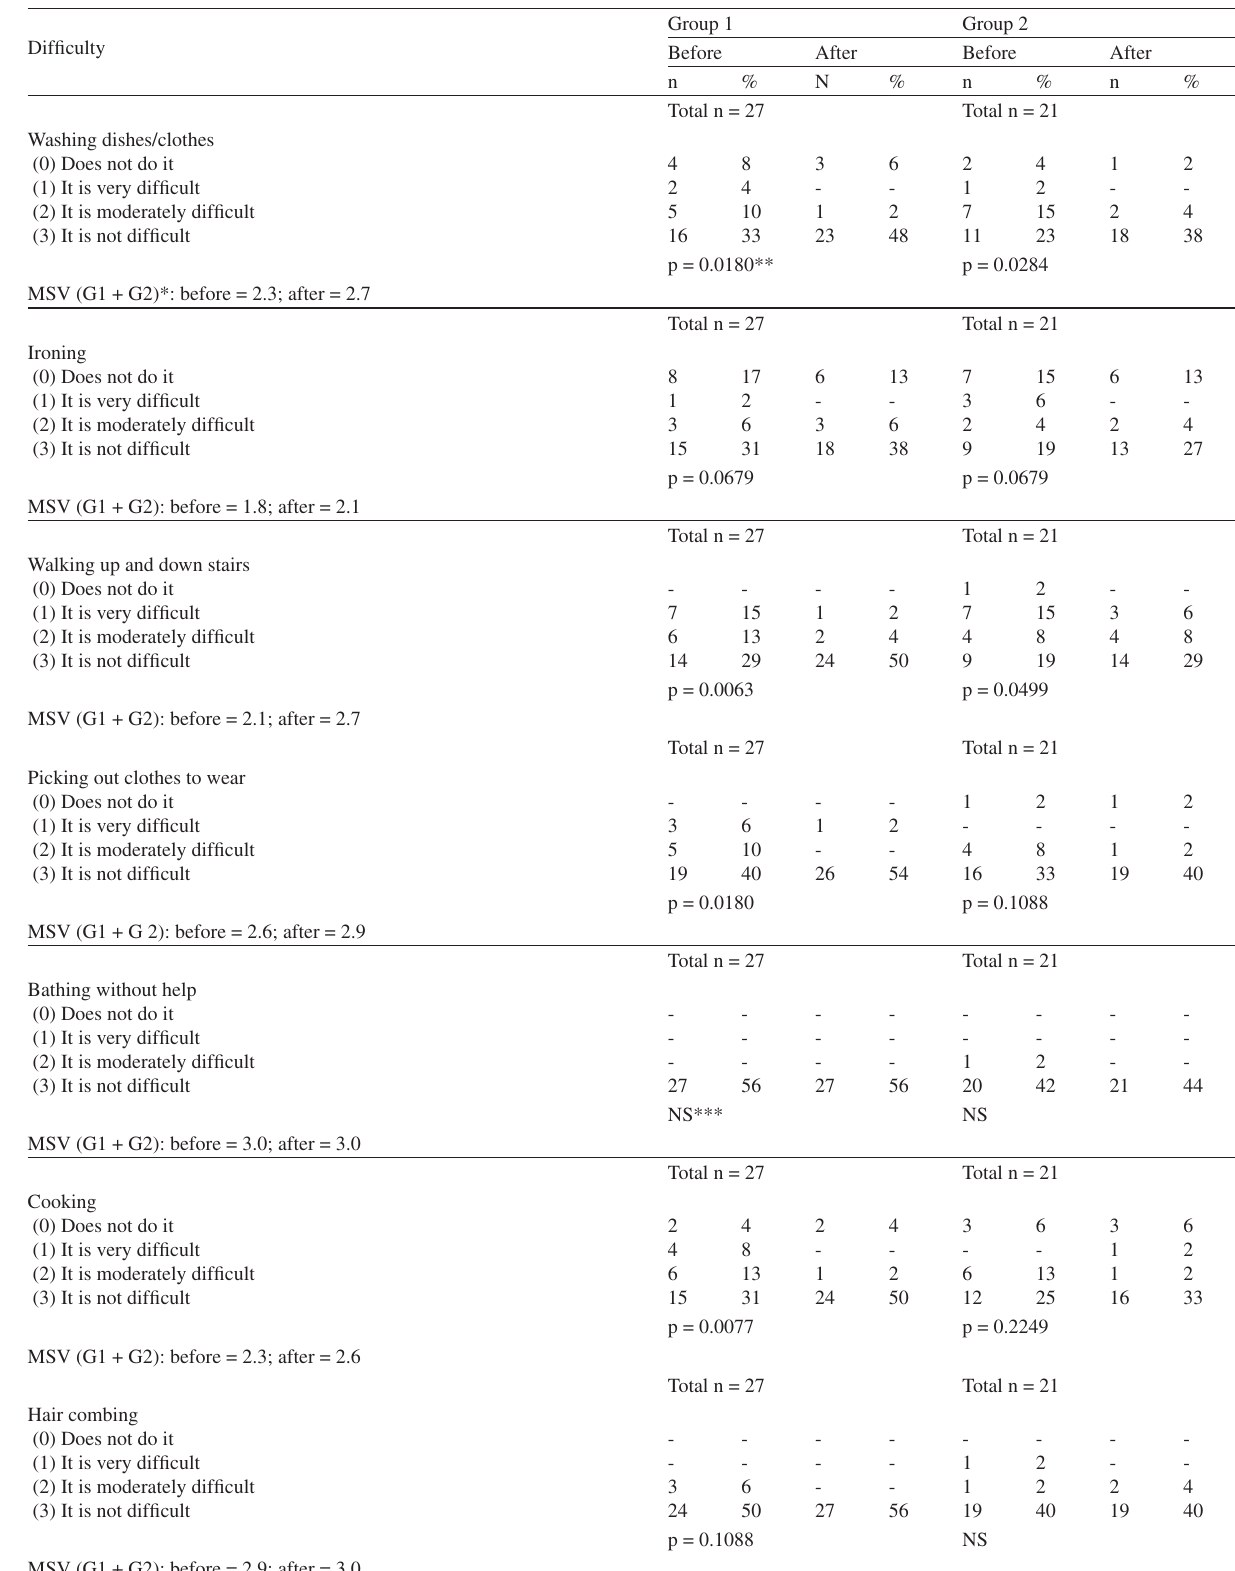
Table 3 - Subjects’ perceptions of difficulties with activities related to mid-range vision before and after capsulotomy. Difficulty